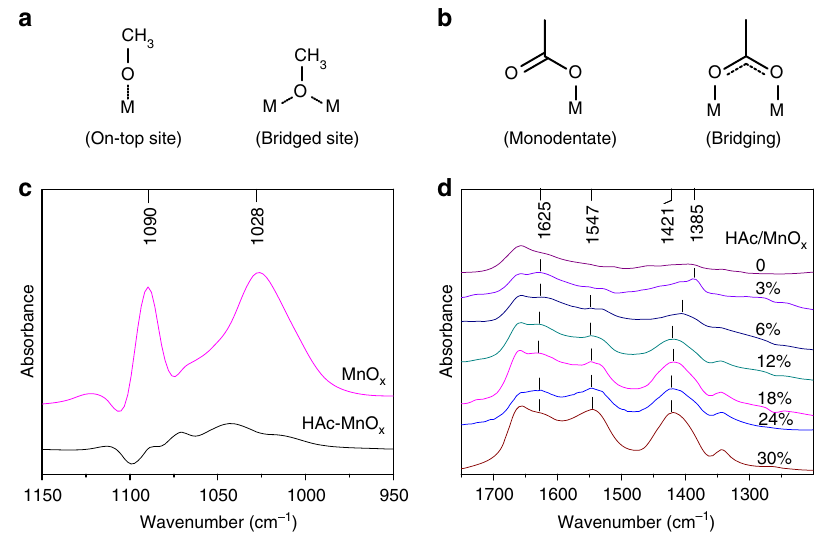
Fig. 2 FT-IR spectra of unmodi fi ed and HAc-modi fi ed MnO x . a Model of the sites for CH 3 OH adsorption on metal oxides. b Coordination modes of the carboxylate adspecies. c FT-IR spectra of CH 3 OH adsorption to unmodi fi ed and HAc-modi fi ed MnO x . d FT-IR spectra of MnO x according the corresponding spectrum. The Mn content was analyzed by inductively coupled plasma atomic-emission spectroscopy